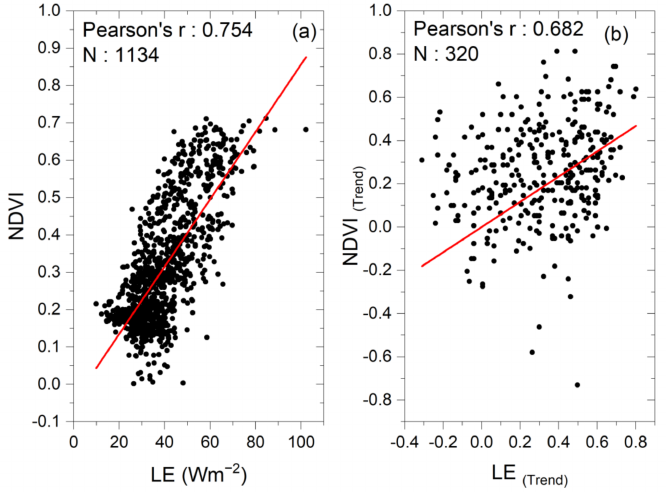
Figure 8. ( a ) Correlation between NDVI and satellite LE; both parameters are obtained from MODIS products. Each point represents a random pixel value taken from mean monthly images of NDVI and satellite LE ( b ) Correlation between NDVI trend and LE trend. A total of 320 random pixels were selected from NDVI and satellite LE spatio-temporal trend images which are produced using the M-K trend